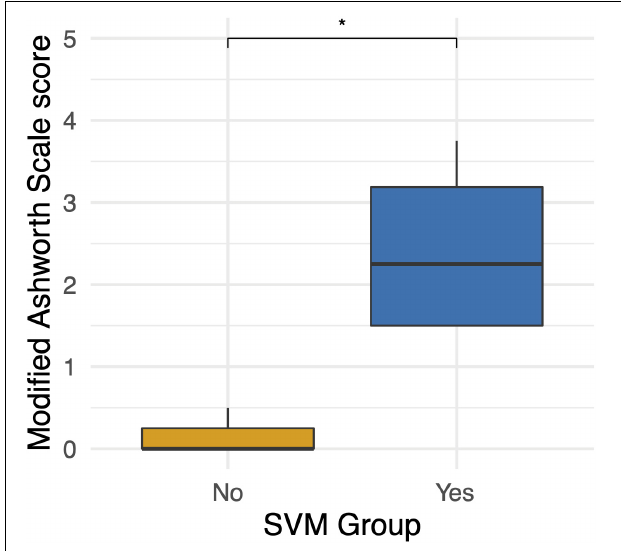
FIGURE 3 | Differences in baseline Modified Ashworth Scale scores between the spontaneous volitional movement (SVM) group (Yes) and non-SVM group (No). Participants in the SVM group had significantly higher spasticity MAS scores than those in the non-SVM group. These differences were present before the start of continuous eSCS therapy. * p <